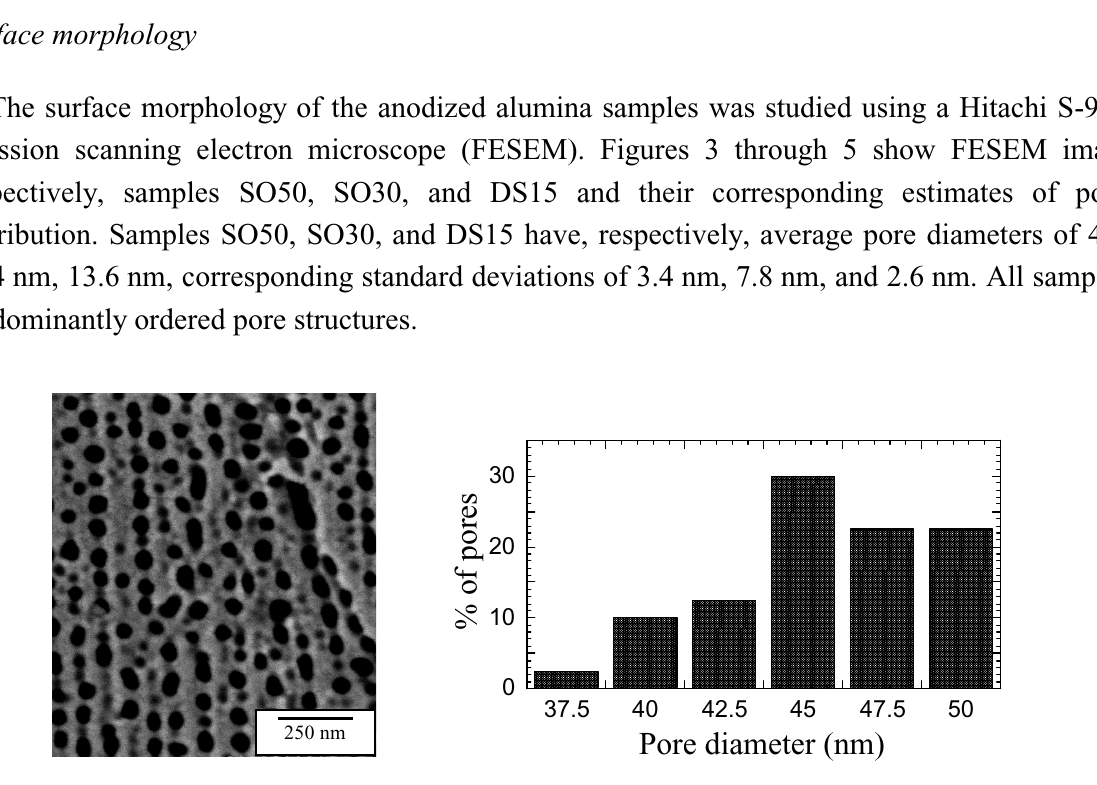
Figure 3. Field emission scanning electron microscope (FESEM) image of sensor SO50 with corresponding pore size distribution.